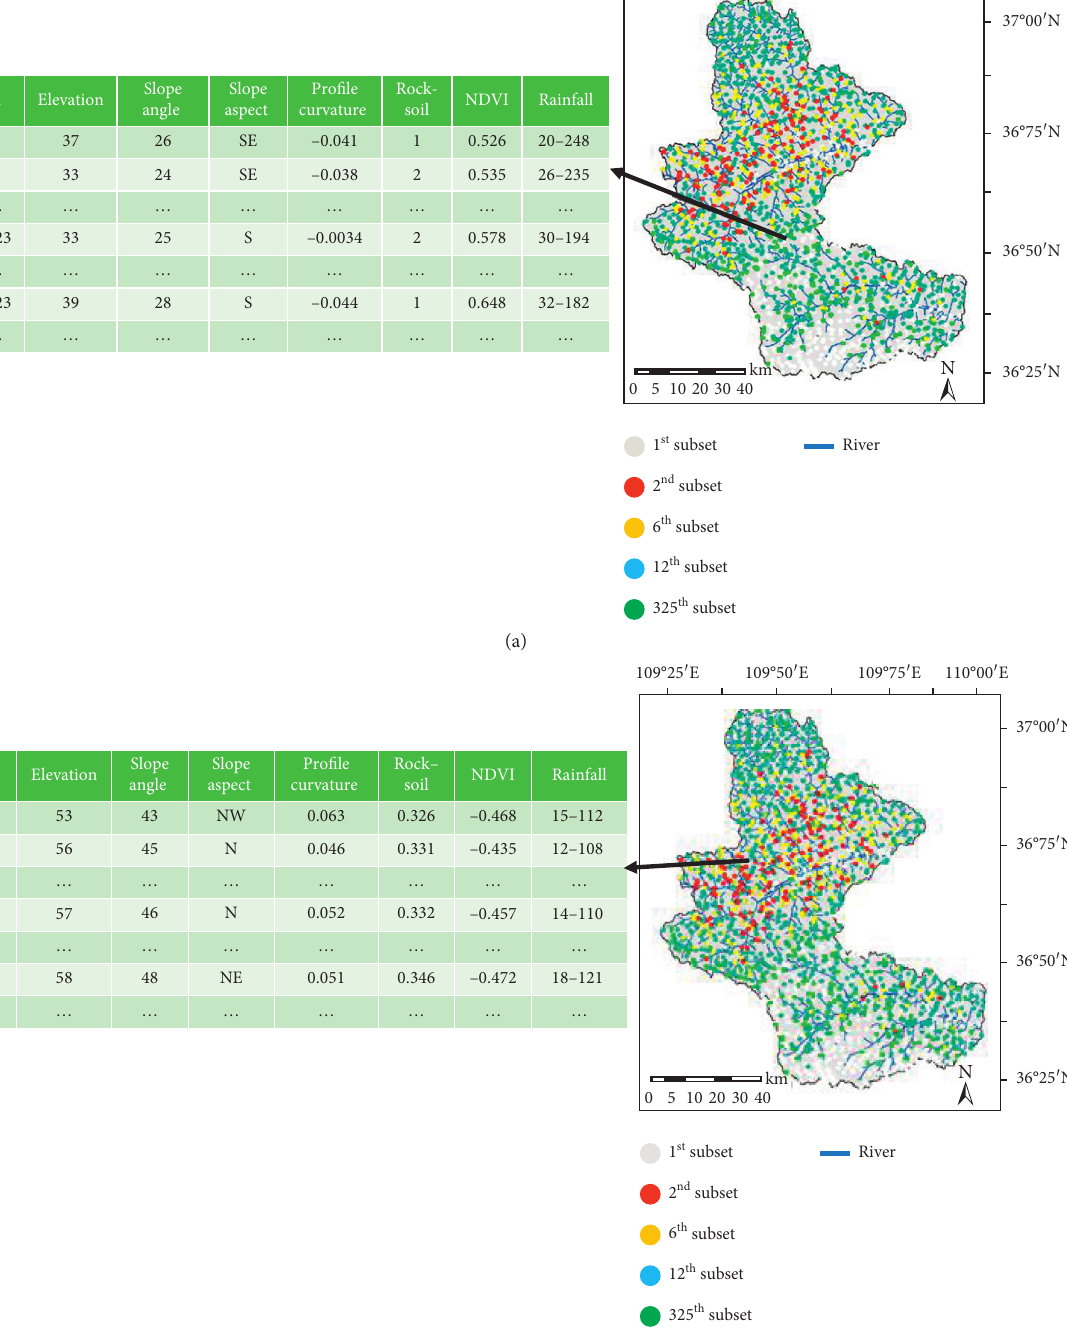
Figure 7: The map of the group based on the CA-AQD algorithm in July: (a) the first group and (b) the second